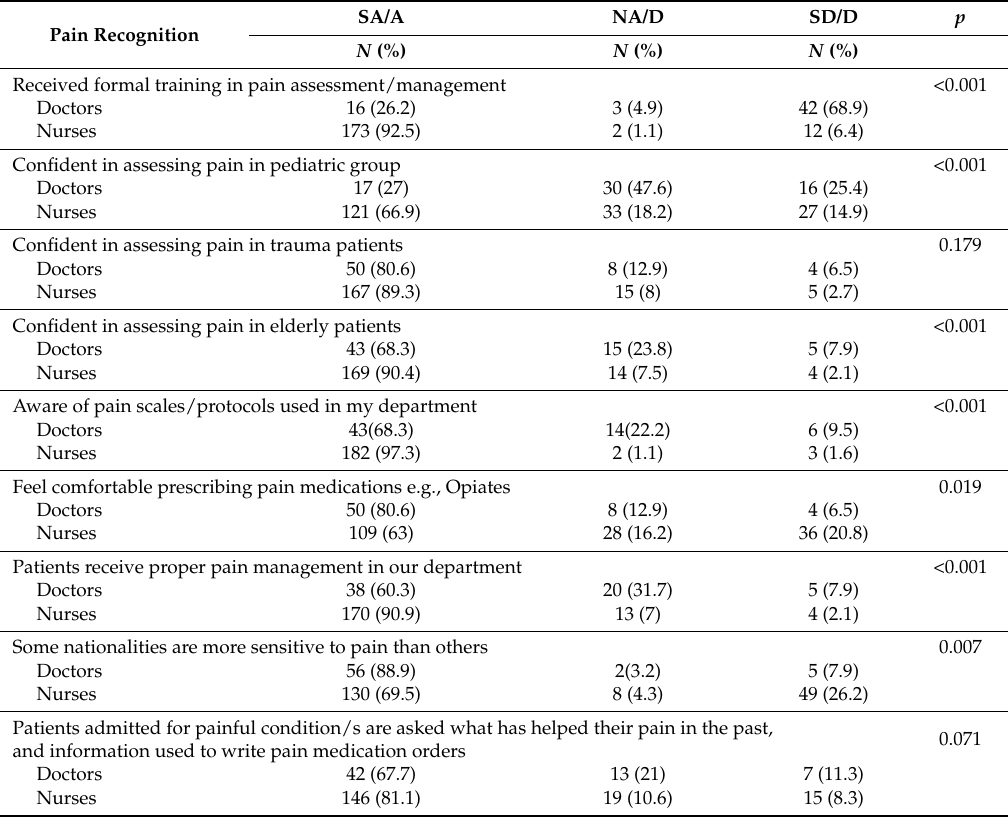
Table 2. Pain recognition among orthopedic doctors and nurses ( N =